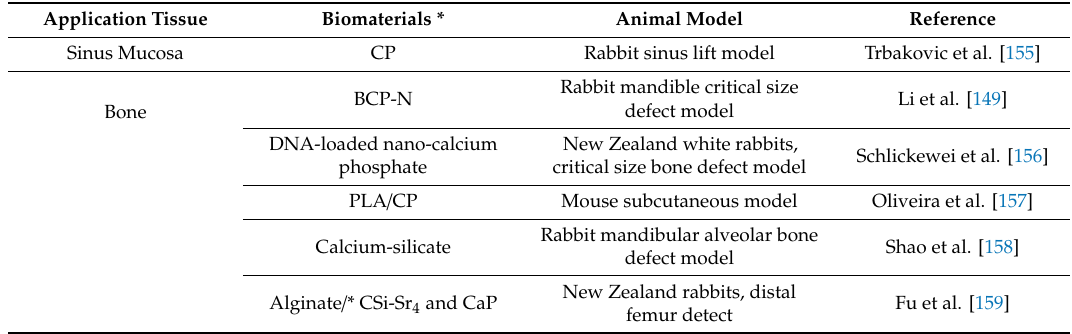
Table 5. Examples of some bioceramics for in situ tissue